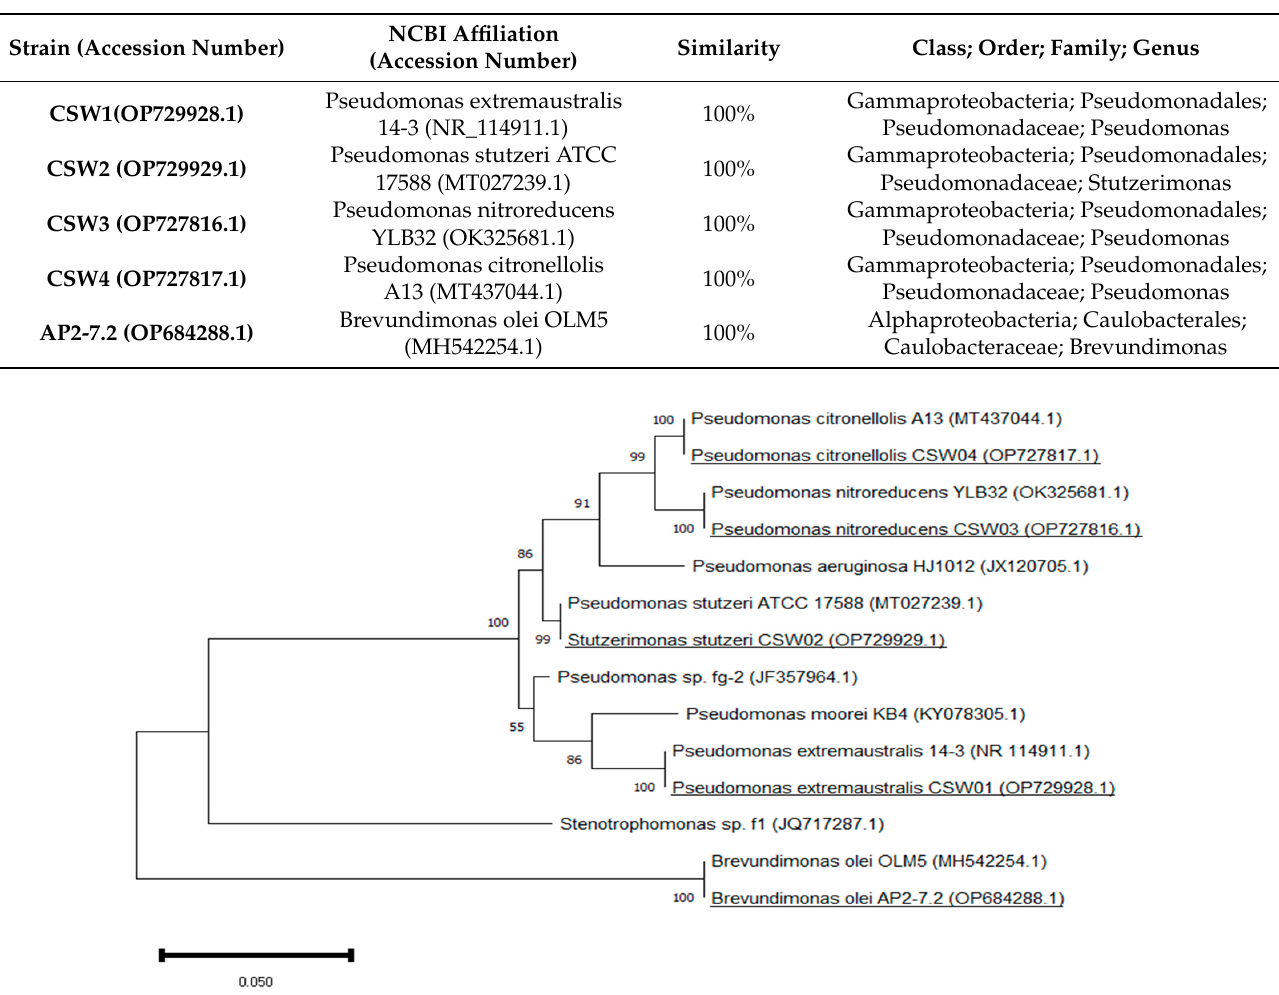
Table 3. Phylogenetic affiliations of bacterial strains isolated from acetaminophen enrichment cultures from sewage sludge.